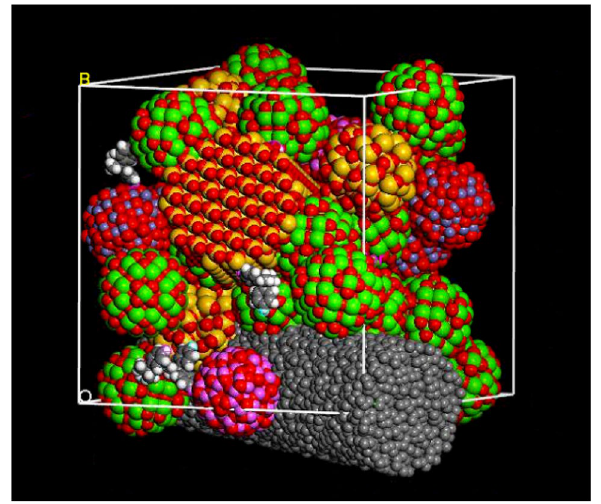
Fig. 14 Molecular dynamics model of high-pressure compacted Portland cement with particle fiber material